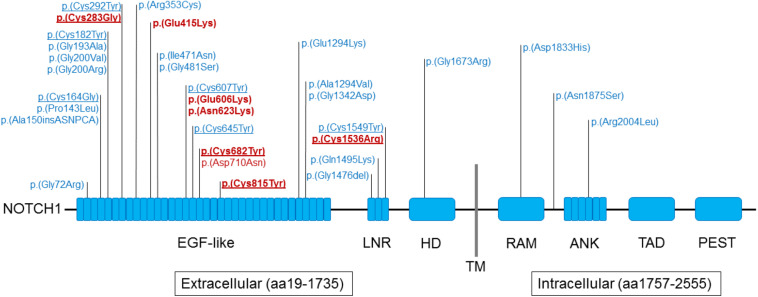
Schematic representation of NOTCH1 domains and rare variants identified in individuals with tetralogy of Fallot. Findings from the current study involving 8 of 175 probands with TOF are indicated in red font; 24 ultra-rare missense variants from the Page et al. study (Page et al., 2019) are indicated in blue font. The seven ultra-rare missense NOTCH1 variants deemed to be either likely deleterious (n = 6) or potentially deleterious (p.Asn623Lys) are indicated in bold red font (details in Supplementary Table S13). Underline indicates those variants that alter evolutionarily conserved cysteine residues; eight located within the EGF-like repeats domain and two in the LNR (Lin12-Notch) domain. Abbreviations: aa, amino acid; ANK, ankyrin; EGF, epidermal growth factor; HD, heterodimerization domain; LNR, Lin/NOTCH repeats; PEST, sequence rich in proline, glutamic acid, serine, and threonine; RAM, RBP-JK–associated molecule region; TAD, transactivation domain; TM, transmembrane domain (aa1736–1756). The protein domains were derived from UniProt (https://www.uniprot.org/uniprot/P46531).